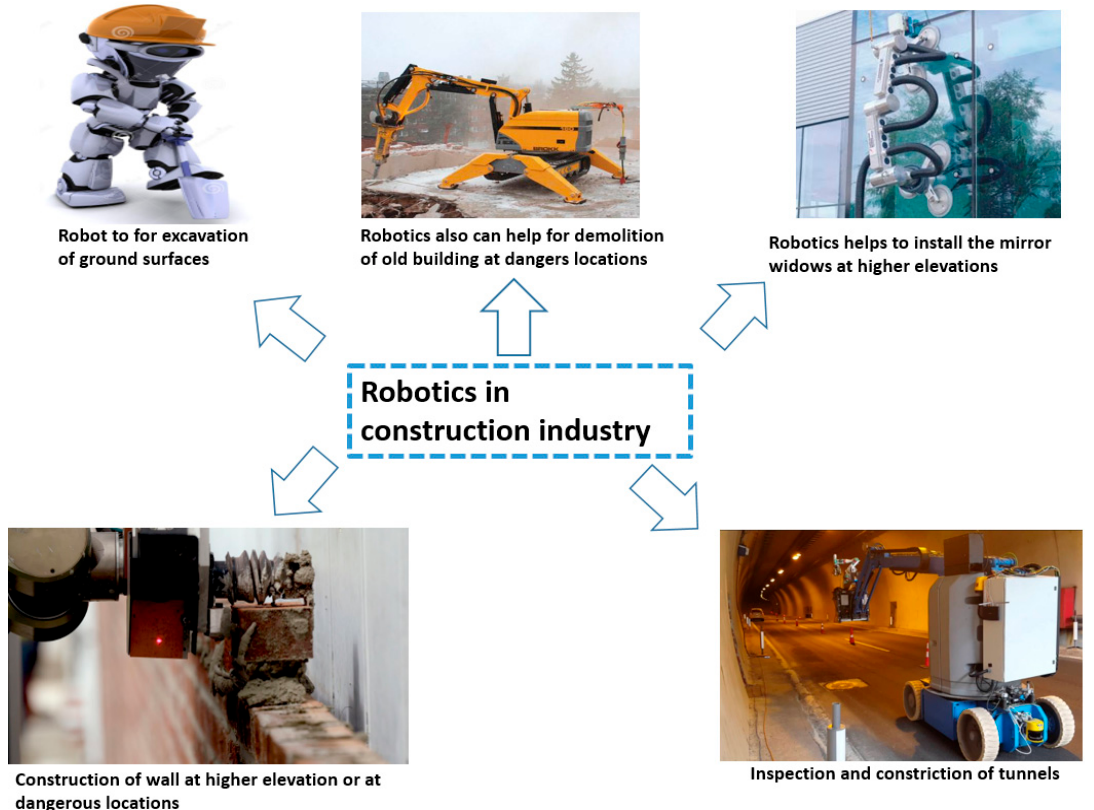
Figure 4. Potential contributions of robotics in the construction industry which helps to reduce fatal accidents.